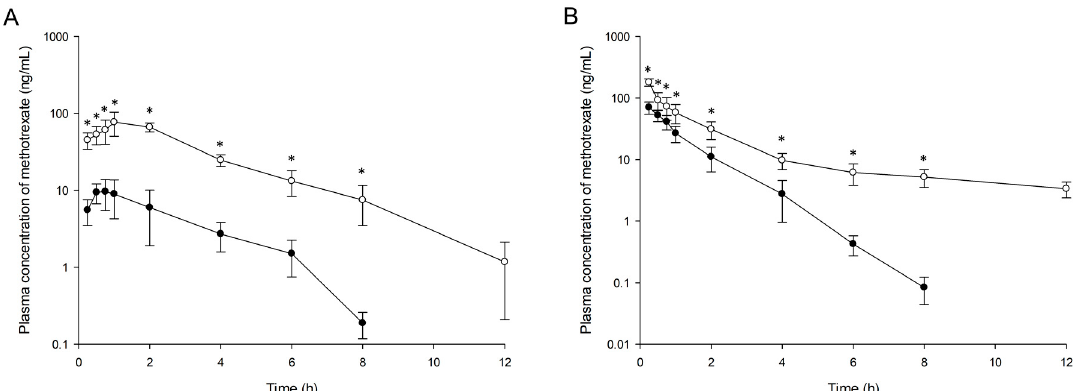
Figure 6. Plasma concentration profiles of methotrexate in rats after oral ( A ) and intravenous ( B ) administration of free methotrexate (- ● -) or methotrexate-loaded nanoemulsion (- ○ -). Data are presented as the mean ± standard deviation ( n = 5). * p < 0.05 compared with free methotrexate.